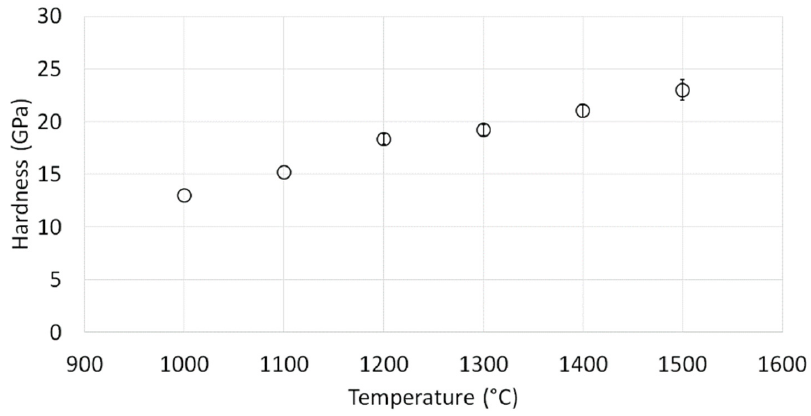
Figure 8. Hardness values for Al 2 O 3 samples.